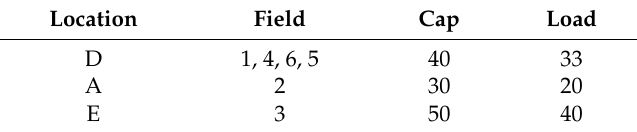
Table 12. The result of the decoding method of the differential evolution (DE)